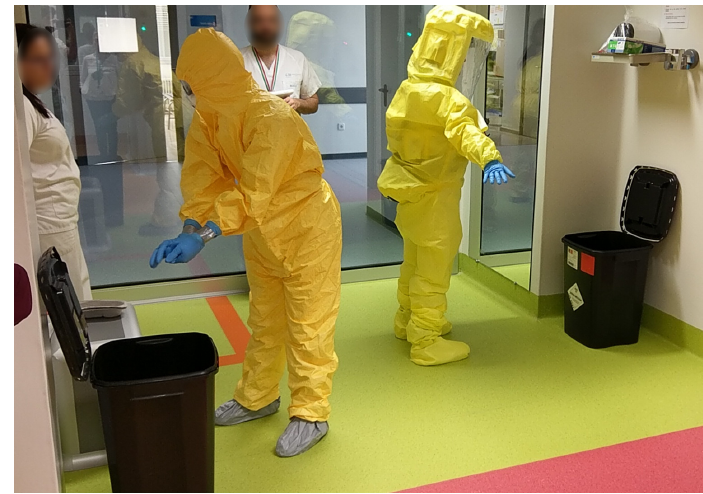
Figure 1. Removal and disposal of gloves inside the changing room (during training